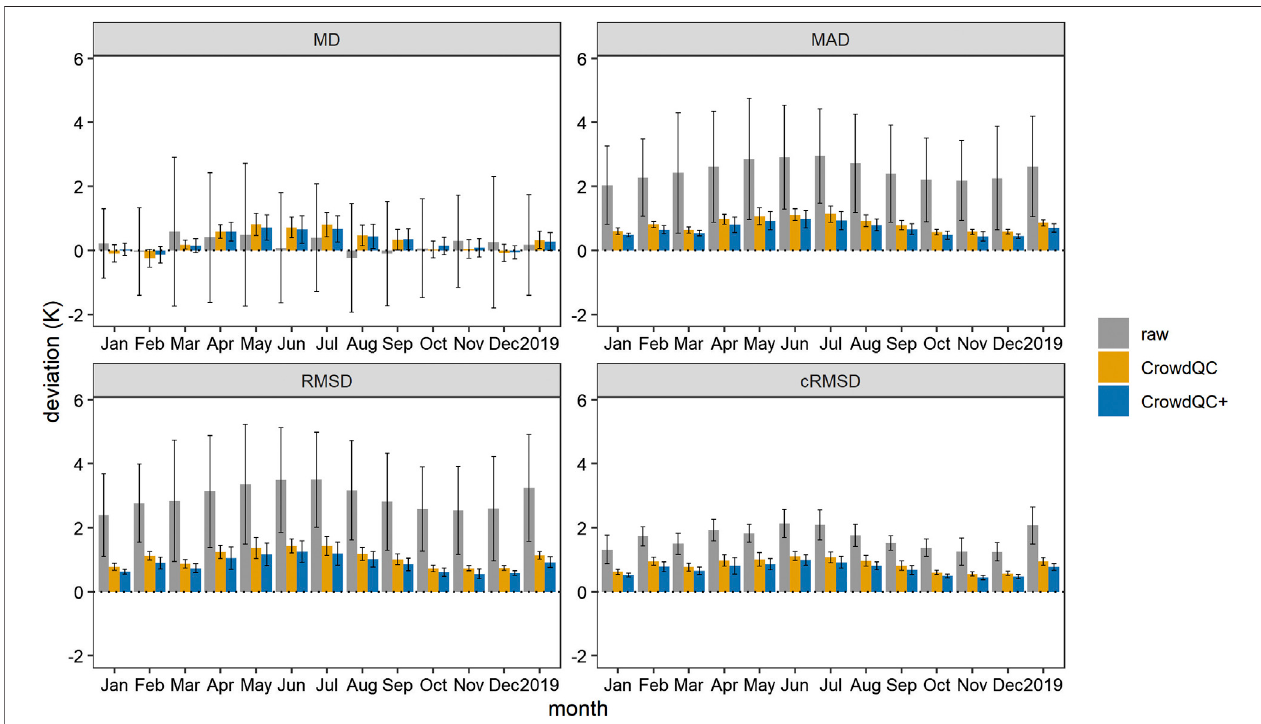
FIGURE 2 | Deviations in hourly air temperature ( ta ) between CWS and PRWS in Amsterdam during 2019 per month and for the whole year. Displayed are values for the raw data set, after applying CrowdQC and CrowdQC+ in their respective default settings (cf. Table 2 ). Shown are values at QC level o3. Deviations were calculated between each PRWS and each CWS within a radius of 2000 m around the respective PRWS, located in the same LCZ type as the PRWS. Deviations were thenaveragedpermonthandyearacrossallCWSandPRWS.ErrorbarsdenotethestandarddeviationacrossallCWSandPRWSpermonthandyear.MD,mean deviation; MAD, mean absolute deviation; RMSD, root-mean-square deviation; cRMSD, centred